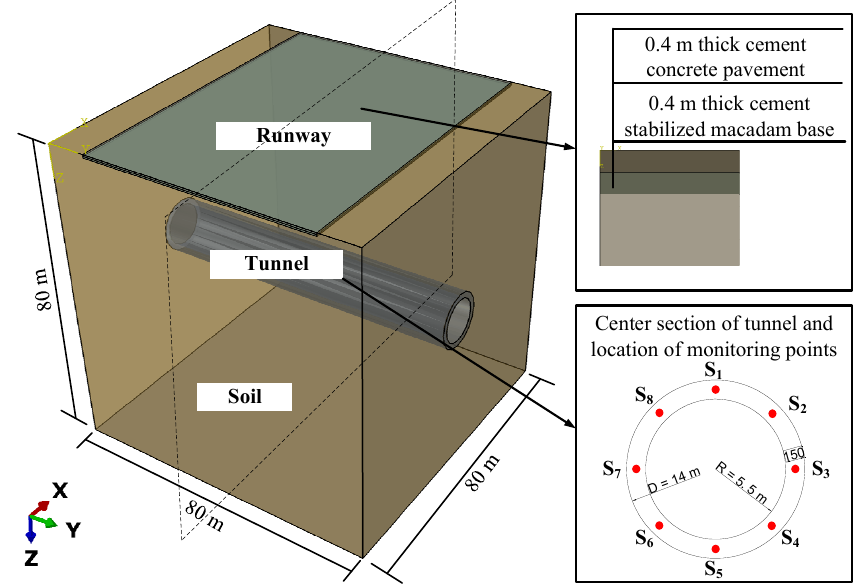
Figure 5. A schematic of the numerical model.